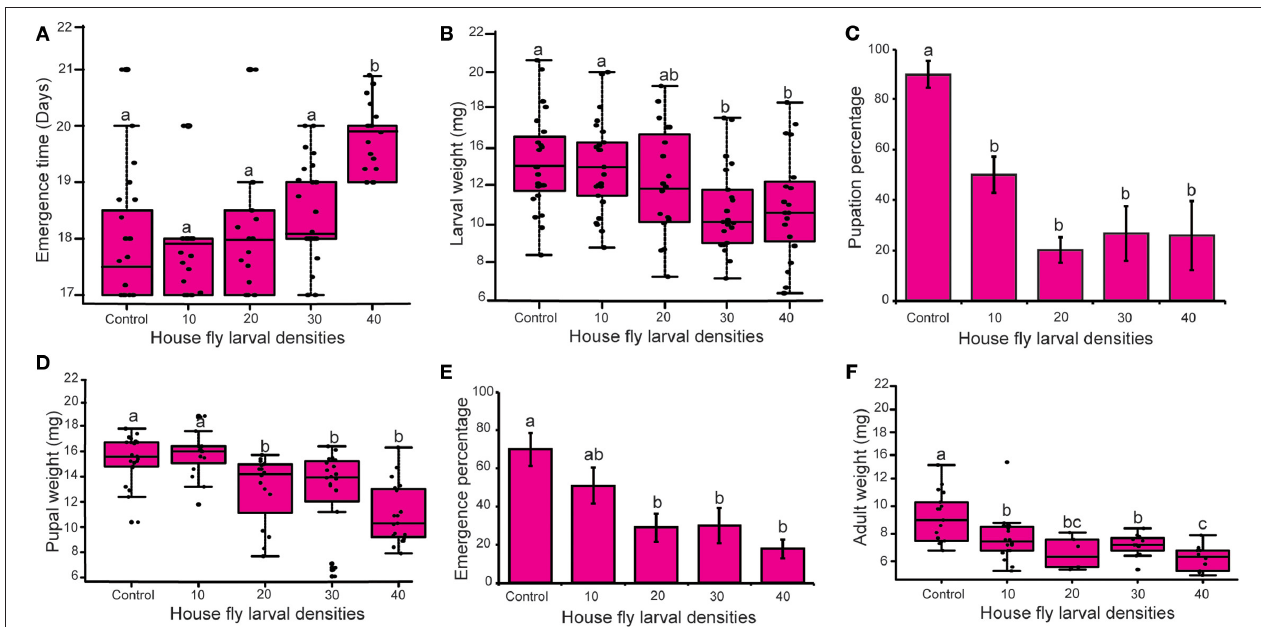
FIGURE 4 | Effect of M. domestica larval density on fitness parameters of S. calcitrans . (A) Boxplot showing the variation of S. calcitrans emergence time across the different larval densities (Kruskal-Wallis test followed by Dunn’s post-hoc test, P < 0.05). (B) Boxplot illustrating the change of S. calcitrans larvae weight across the different larval densities (ANOVA test followed by DTK’s post-hoc test, P < 0.05). (C) Histograms depicting the pupation percentages of S. calcitrans across the different larval densities (GLM with binomial distribution followed by Tukey post-hoc mean separation test, P < 0.05, n = 10), (D) Bar chart showing the variation of S. calcitrans pupae weight across the different larval densities (Kruskal-Wallis test followed by Dunn’s post-hoc test, P < 0.05). (E) Bar chart illustrating the variation of S. calcitrans emergence percentage across the different larval densities (GLM with binomial distribution followed by Tukey post-hoc mean separation test, P < 0.05, n = 10). (F) Boxplot depicting the variation of S. calcitrans adult weight across the different larval densities (ANOVA test followed by DTK’s post-hoc test, P < 0.05). On each boxplot, the minimum and maximum values of all the data are represented by the ends of boxplot whiskers. On the bar charts, the error bars indicate the standard error of the mean (SEM). Treatments with different lowercase letters are significantly different from each